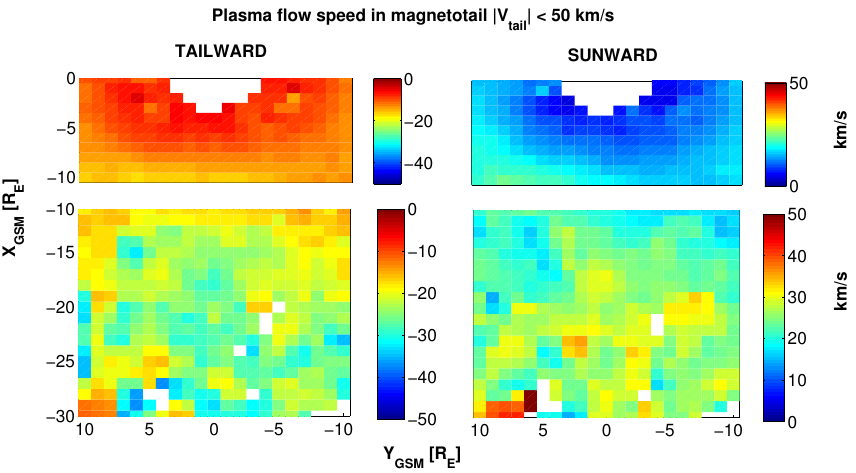
Figure 1. Average plasma flow pattern for slows flows ( | V tail | < 50kms − 1 ) in 2008–2011. The colors show the average speed of the bin.